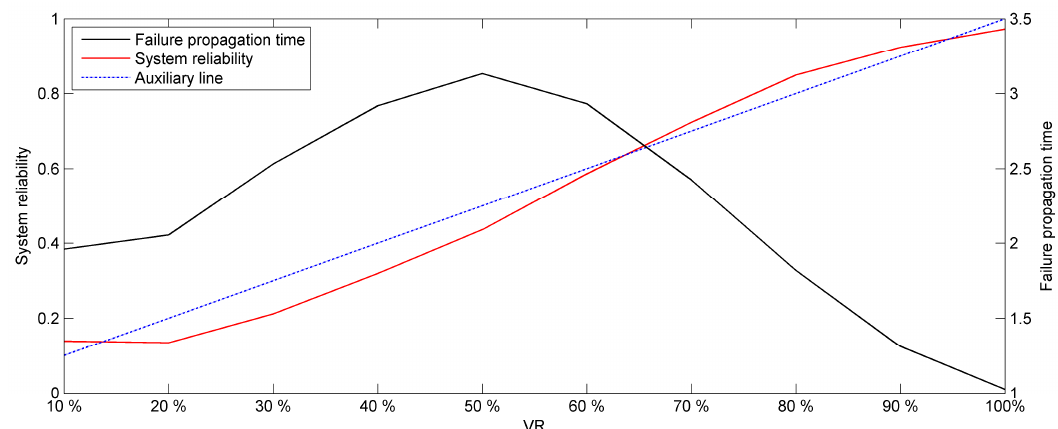
Figure 4. The relationship of system reliability, failure propagation time, and valve ratio ( VR ) .